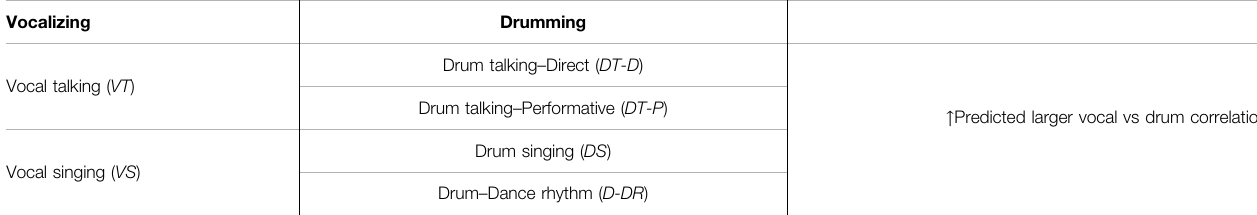
TABLE 2 | Categories of speech and drumming that were compared.